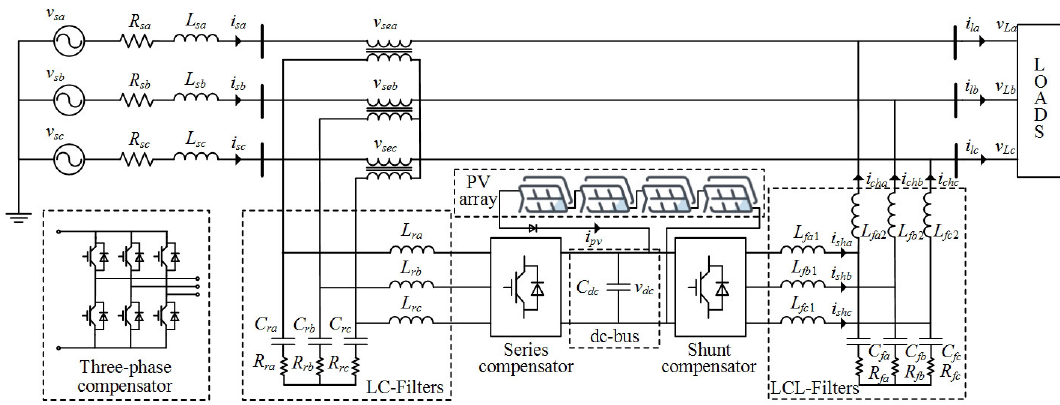
Figure 1. The complete configuration of the proposed photovoltaic system integrated unified power quality